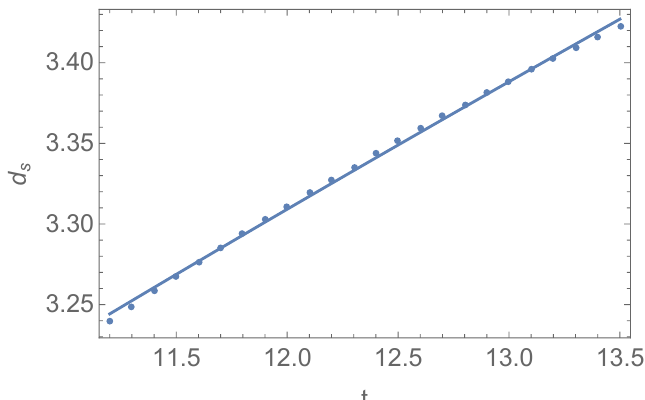
Figure 6 . Fit of the intermediate regime of the ordered-phase violet curve in figure 4, corresponding to an average of three squares per vertex, to the CH spectral function (4.5).